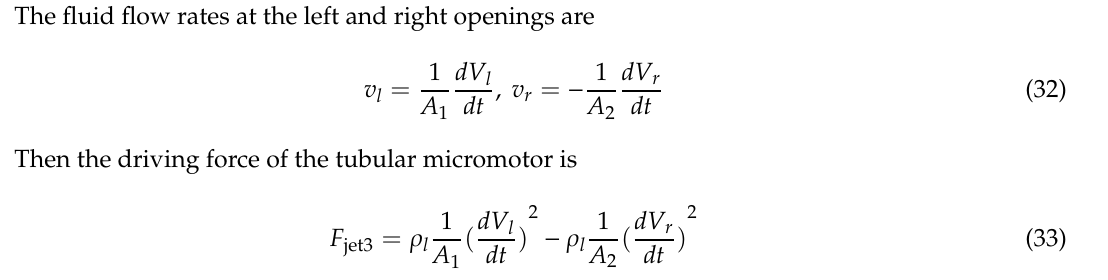
Figure 5. A schematic diagram of the ejection stage of the bubble at the opening of the micromotor. The radius of the two spheres is R 1 and R 2 , respectively, and the volume of the two spheres is V 1 and V 2 .